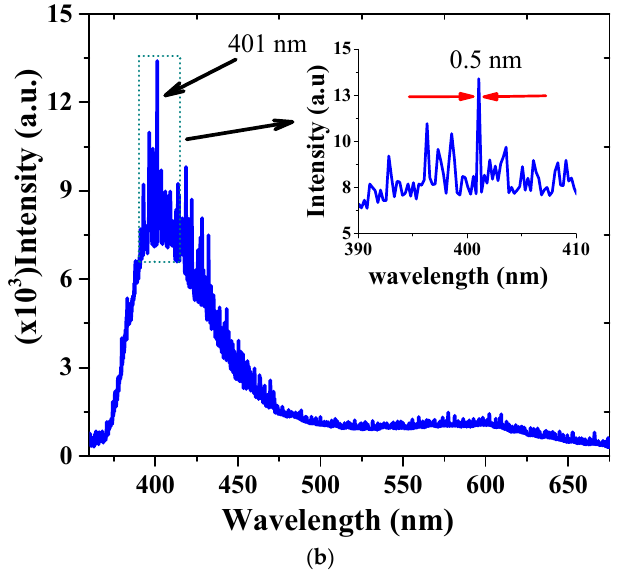
Figure 7. ( a ) the threshold and LIF spectra of compound 5d + ZnO mixer solution in toluene; ( b ) the random laser spectra of 5d + ZnO mixer solution in toluene, inset the zoom of same for wavelength range from 390 nm to 410 nm, shows the random laser peak at 401 nm with a sharp 0.5 nm FWHM.